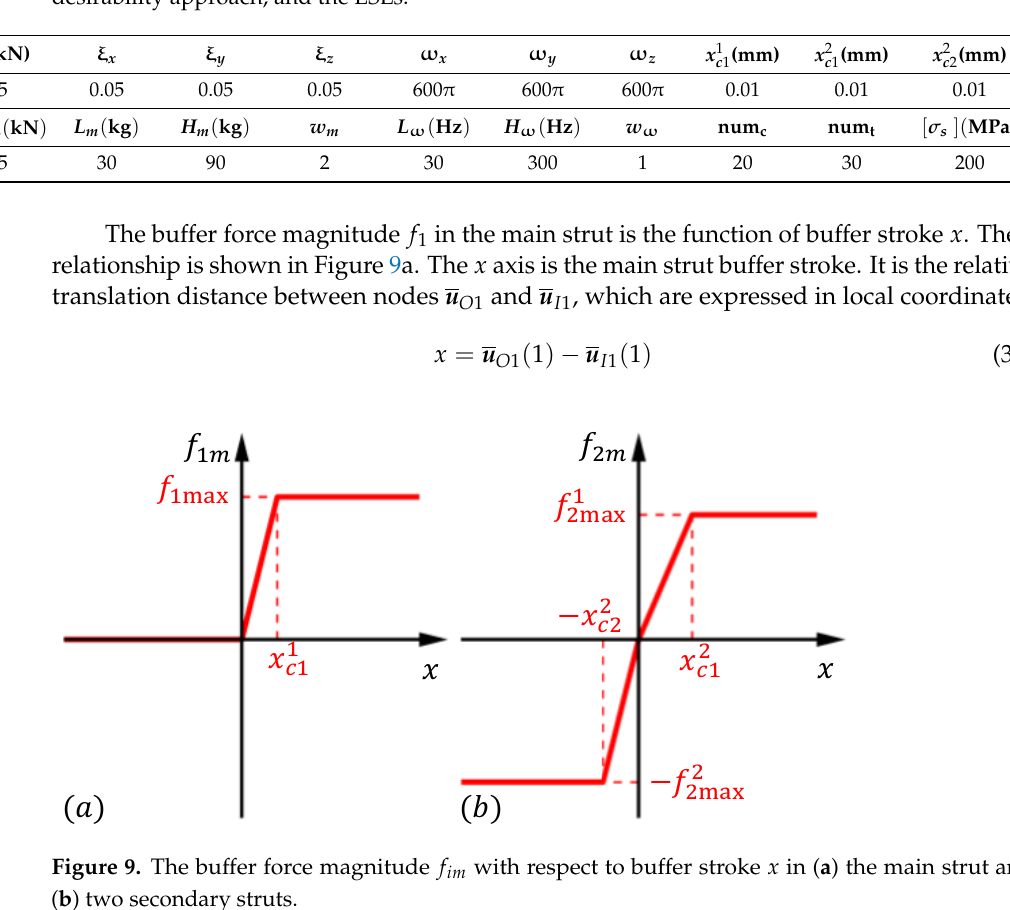
Table 2. Parameter values related to the landing force F f , the buffer force magnitude f im , the desirability approach, and the ESLs.